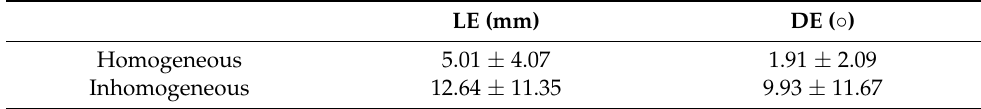
Table 4. Statistics of localization performance with SNR = ∞